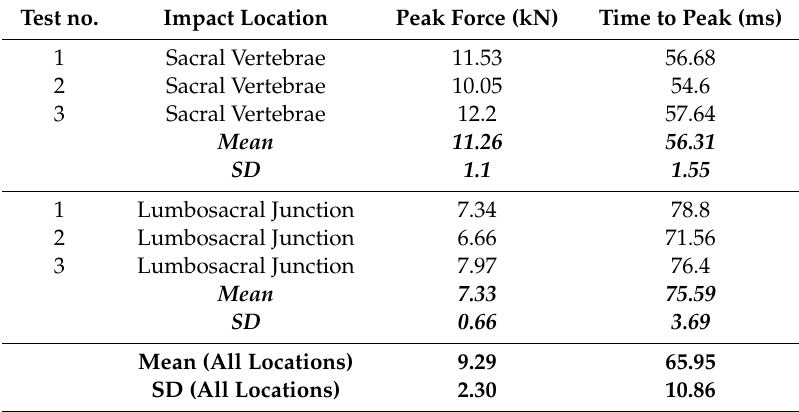
Figure 7. Helmeted drop test force–time history plots for horse 2. ( a ) Lumbosacral junction vertebrae impact location. ( b ) Sacral vertebrae impact location. Table 3. Helmeted drop test results for horse 2.